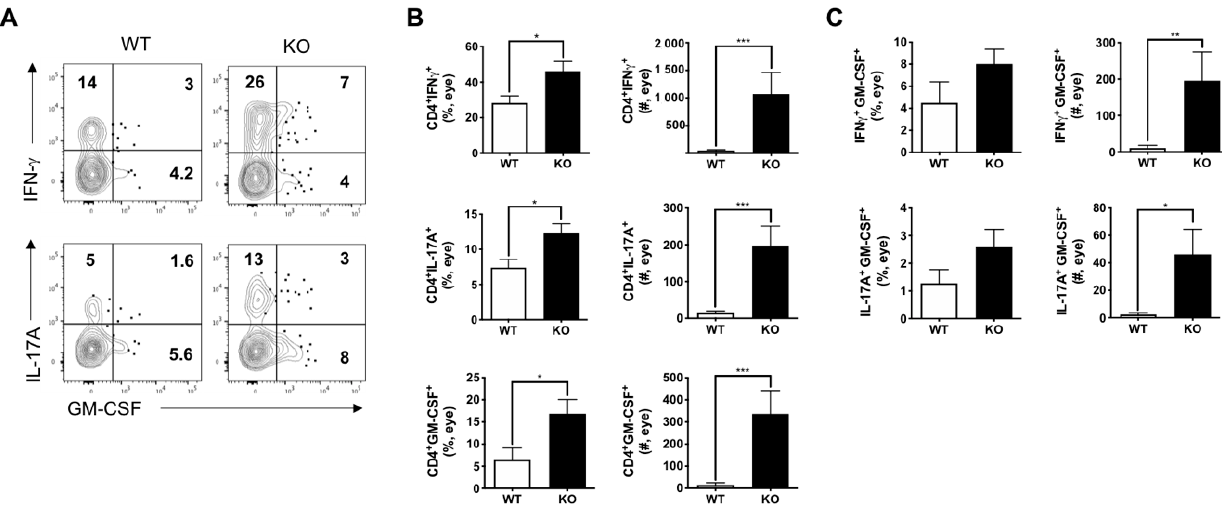
Figure 2. Ocular Th1 and Th17 responses increased in IL-27R α − / − EAU mice. Inflammatory cells were isolated from the eyes from WT and KO EAU mice at the peak of disease and assessed for FCM analysis. ( A ) Representative plots of IFN- γ , IL-17A, and GM-CSF production in the inflamed eyes. Cells were gated on CD4 + population. ( B ) Frequency (%) and actual number (#) of IFN- γ -, IL-17A-, and GM-CSF-producing CD4 + T cells in the EAU eyes. ( C ) Frequency (%) and actual number (#) of IFN- γ + GM-CSF + and IL-17A + GM-CSF + dbl-pos CD4 + T cells in the EAU eyes. Data represent the means ± SEMs (WT: n = 5 eyes; KO: n = 9 eyes), * p < 0.05, ** p < 0.01, *** p < 0.001, Mann–Whitney U test.